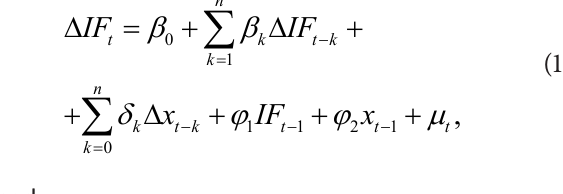
Table 1. Variables definition and previous works used